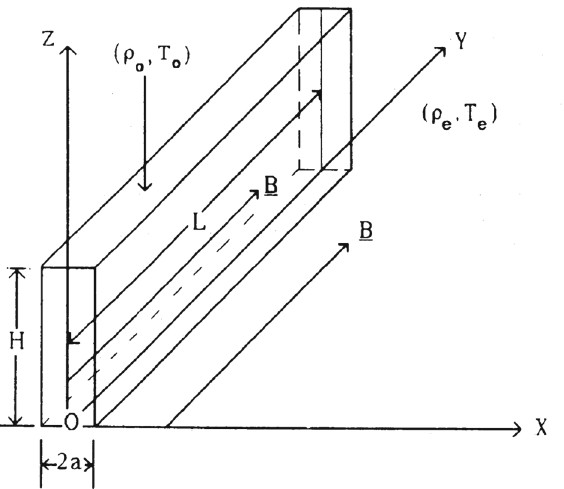
Fig. 36 Sketch of the prominence slab model with longitudinal magnetic field used by Joarder and Roberts (1992a).Theseauthorsassumedthatthecoronalenvironmentinwhichtheprominenceisembeddedextends infinitely in the x -direction. In this figure, the width of the prominence is denoted by 2 a , whereas in our text 2 x p is used. Image reproduced with permission from Joarder and Roberts (1992a), copyright by